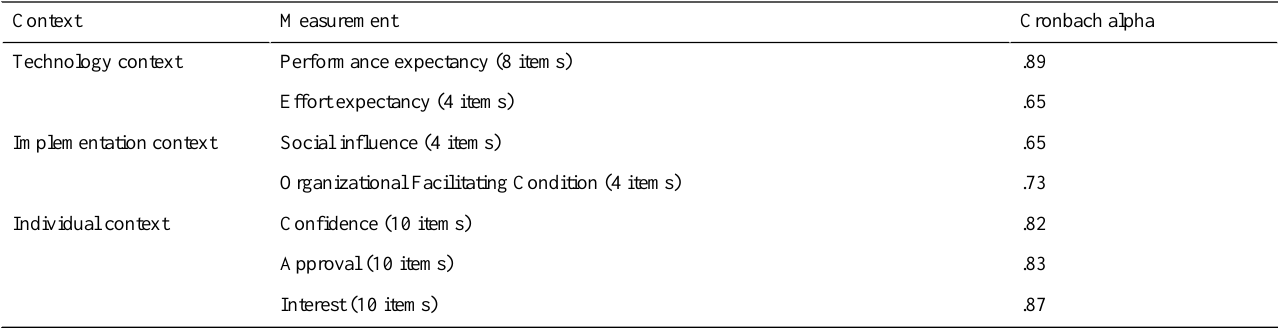
Table 2. Measurement and Cronbach